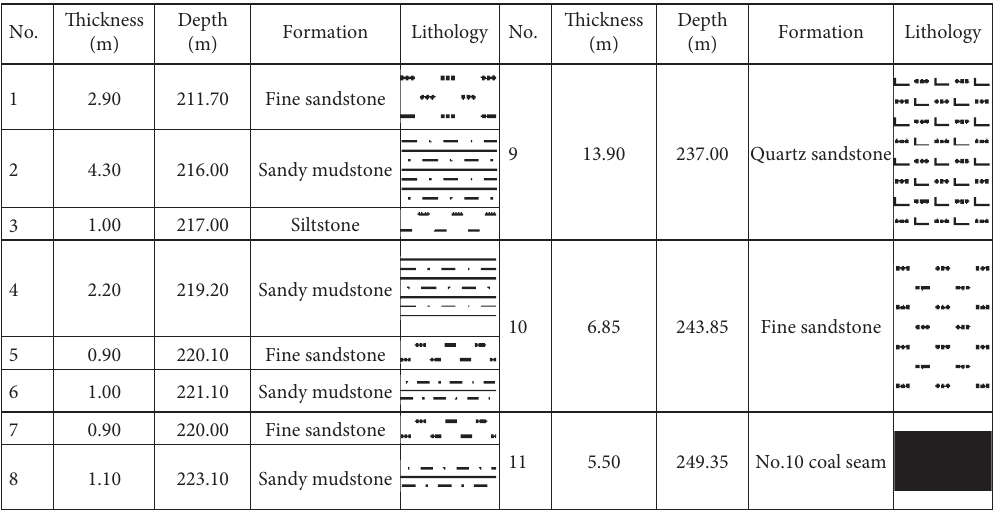
Figure 1: Generalised stratigraphic column of the 1007 working